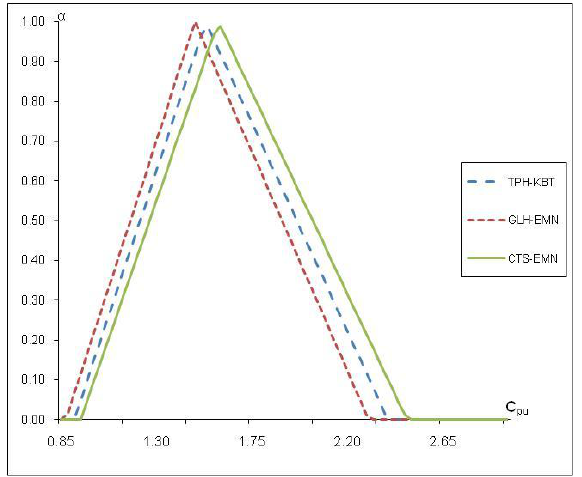
Fig. 10. The membership functions of the index for